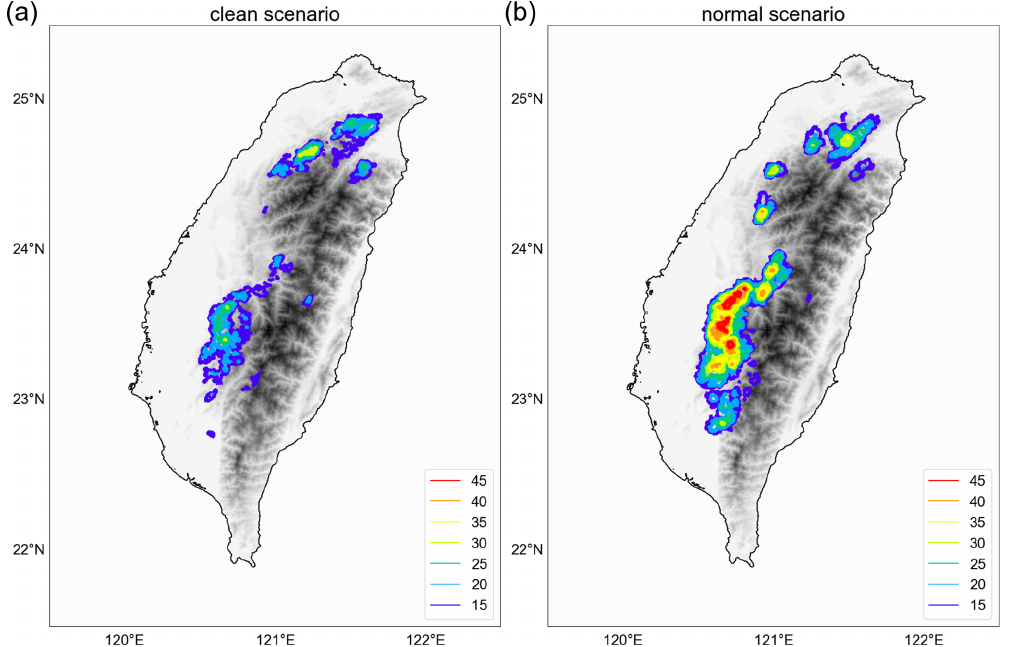
Figure 6. The occurrence counts of convective systems with a maximum rain rate greater than 100mmh − 1 under (a) the clean scenario and (b) the normal scenario.